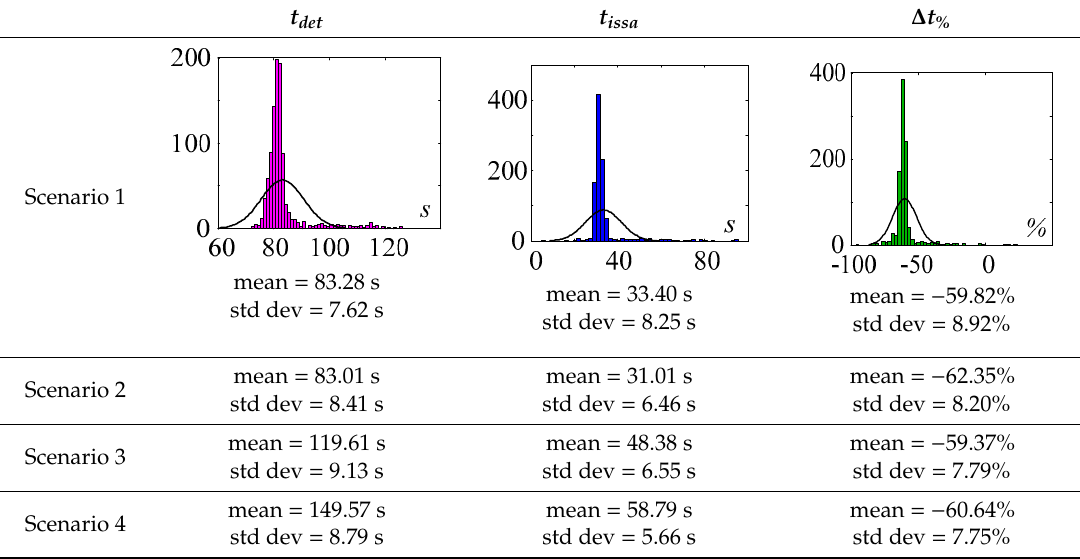
Table 4. Execution time performance evaluation, case A (simulation time step 1 · 10 − 6 s), Computer 1 *. t det t issa ∆ t % t det t issa Δ t